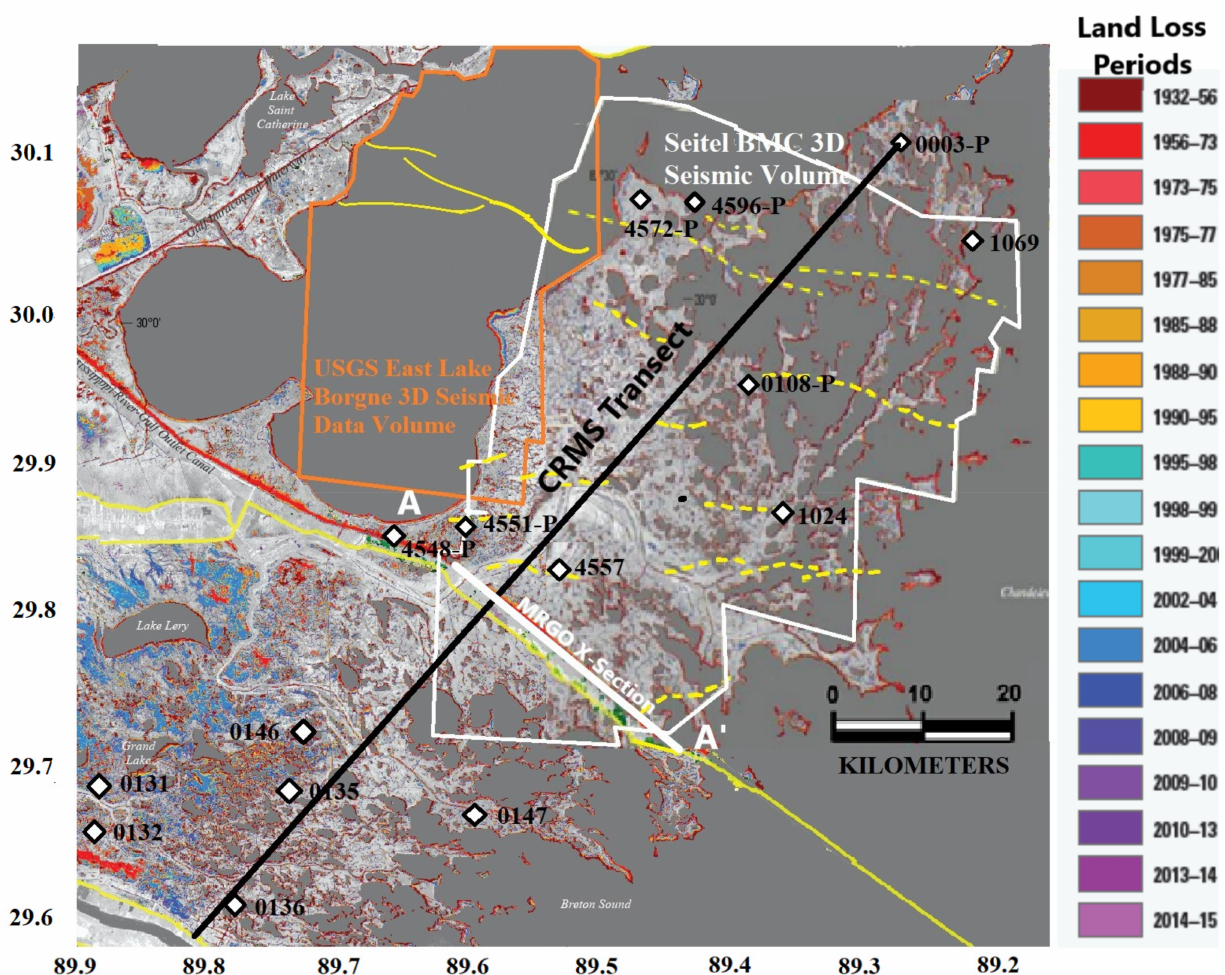
Figure 3. Dashed yellow lines on Biloxi Marsh peninsula are traces of growth faults projected from 1200 m onto the 2016 map of persistent land loss colored by loss interval [10]. Projected Biloxi Marsh faults (dashed yellow) are on trend with those of similar character (solid yellow) projected from 3D seismic and CHIRP data acquired in Lake Borgne by Western Geophysical, USGS and UNO [57–61]. Numbered CRMS stations (diamonds) along transect from northern tip of Biloxi Marsh to the east bank of the Mississippi River near Bohemia. A ‘P’ following the CRMS station number indicates that the SET is anchored in the Pleistocene Prairie terrace. (Figure S4). A to A’ marks a geologic cross-section in the MRGO right-of-way (Figure